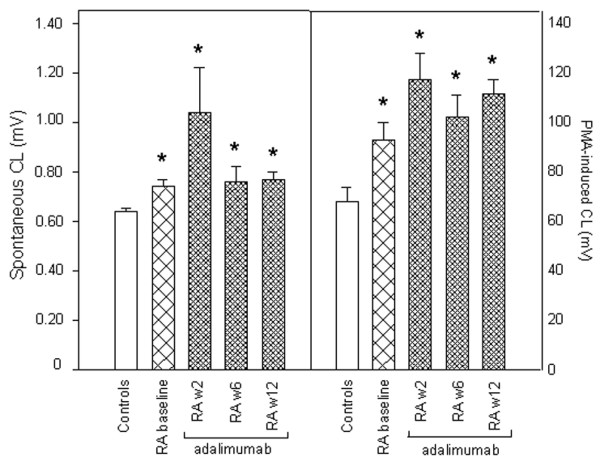
Effect of adalimumab on neutrophil chemiluminescence production. Neutrophils were obtained as described in the legend to Fig. 1 and then tested for chemiluminescence (CL) production in resting conditions (spontaneous CL) or in response to 5 ng/ml phorbol 12-myristate 13-acetate (PMA-induced CL). Results are expressed as mean ± standard error of the mean of peak CL values. *P < 0.05 versus control individuals. RA, rheumatoid arthritis.